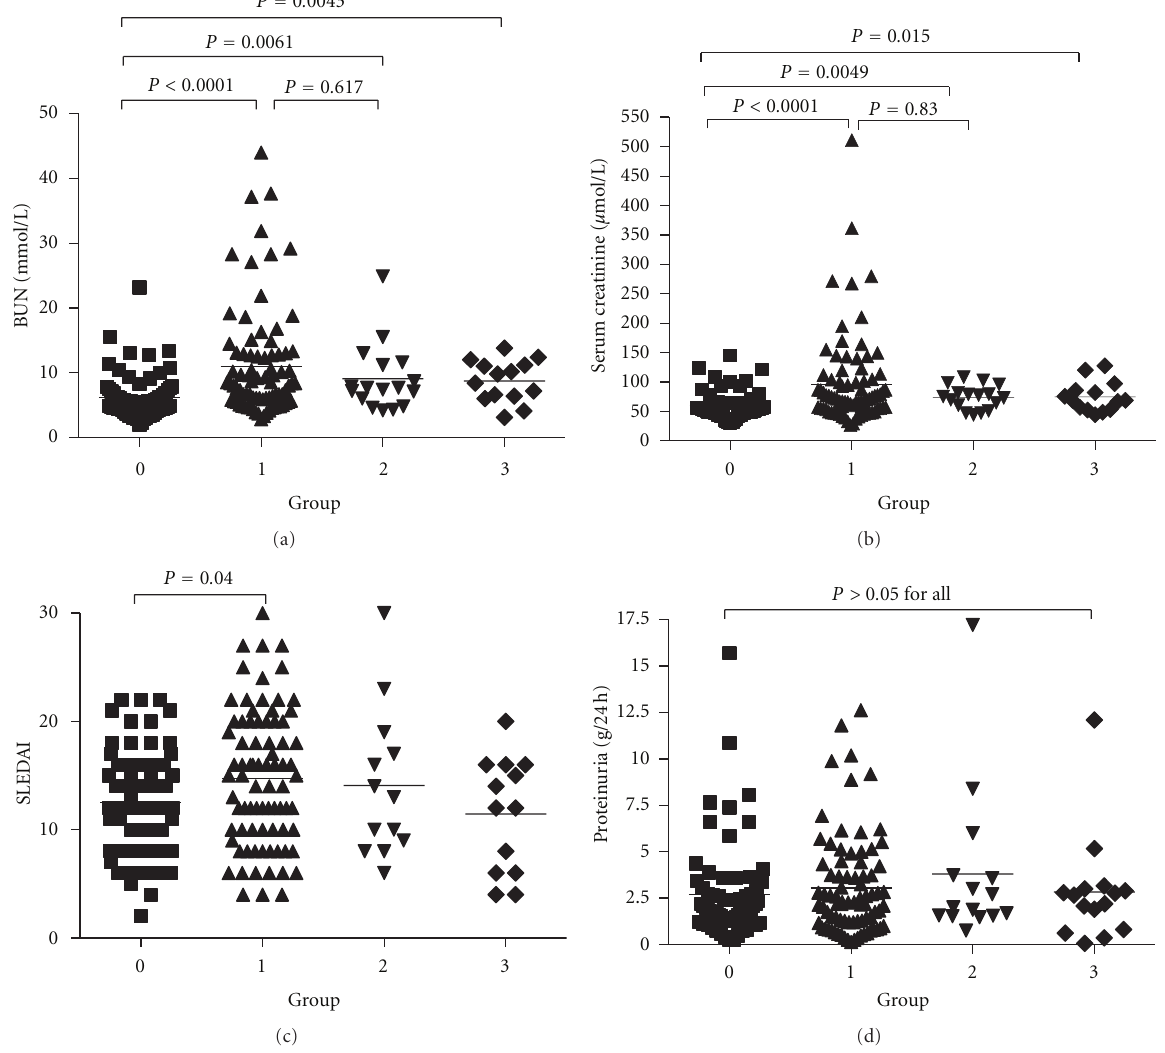
Figure 2: Serum blood urea nitrogen and creatinine levels, SLEDAI, and 24-hour urinary protein level in four di ff erent groups of LN